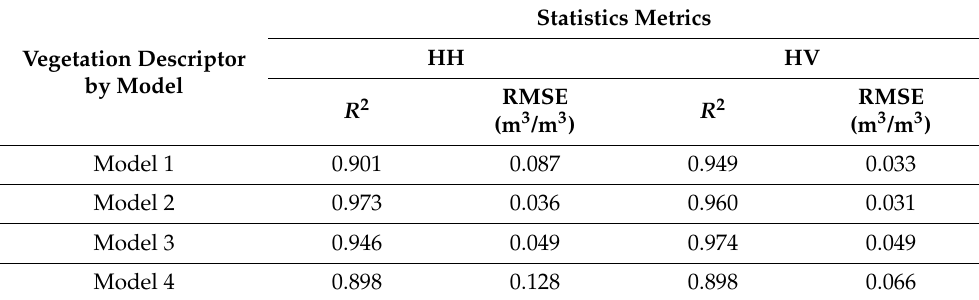
Table 5. R 2 and the RMSEs for the soil moisture data retrieved and observed from an oil palm crops (in m 3 /m 3 ) using PALSAR-2, given according to the proposed